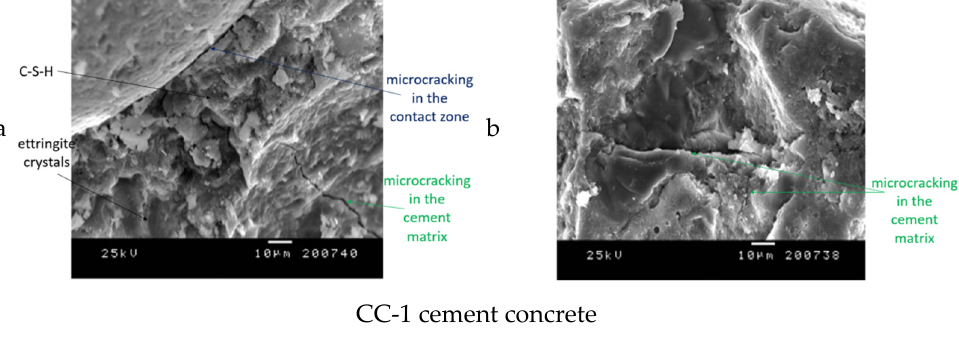
Figure 20. Change of the average compressive strength of CC-1 and CC-2 concrete as a function of the number of cycles—scheme B.